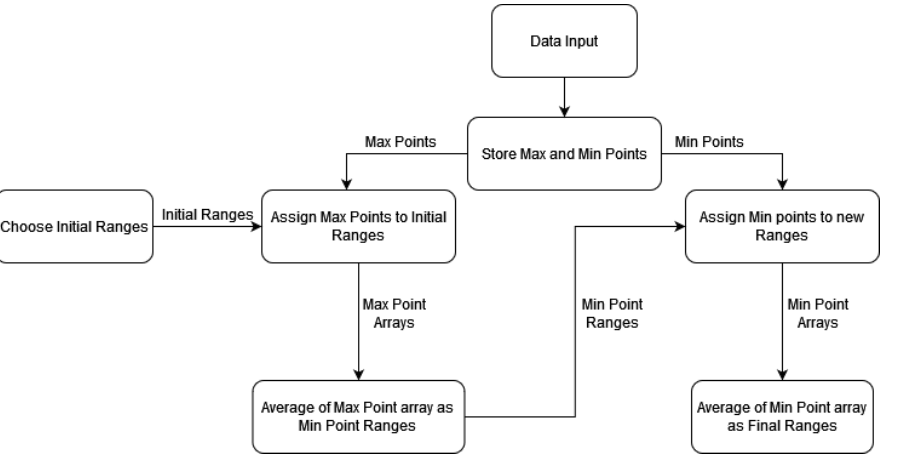
Figure 4. Frequency bandwidth calculation procedure.